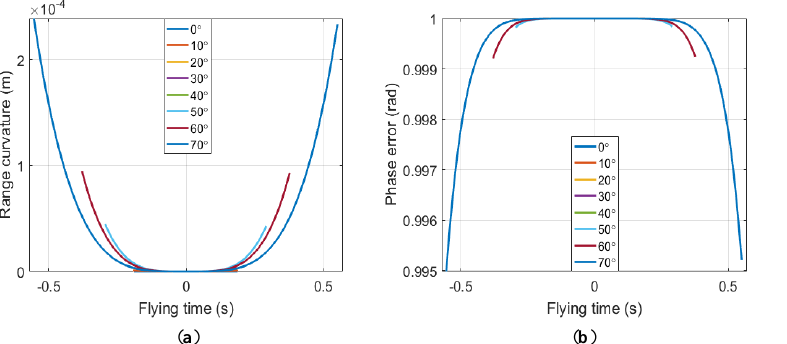
Figure 8. Cubic phase spatial variations for different squint angles. ( a ) Cubic RCM. ( b ) Cubic phase error in azimuth.